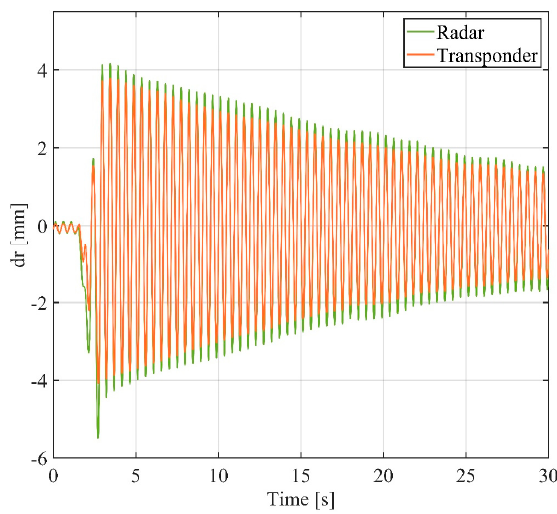
Figure 8. Radar image of the two corner reflectors fixed on the metallic bar.